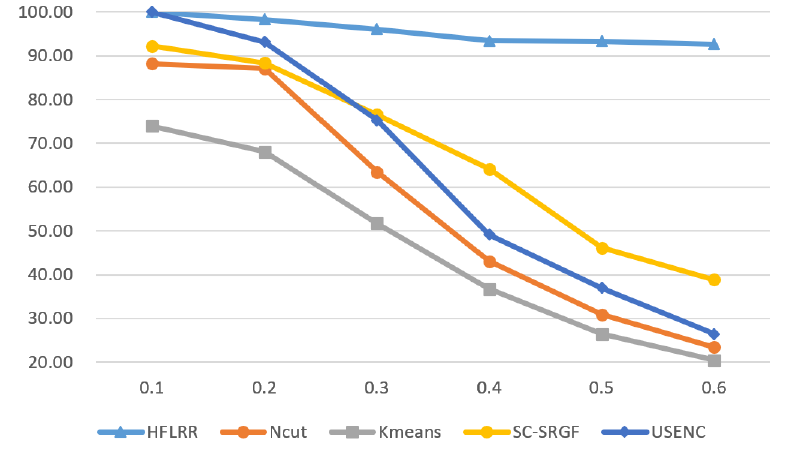
Figure 3. The clustering accuracy varies with the level of Gaussian noise.